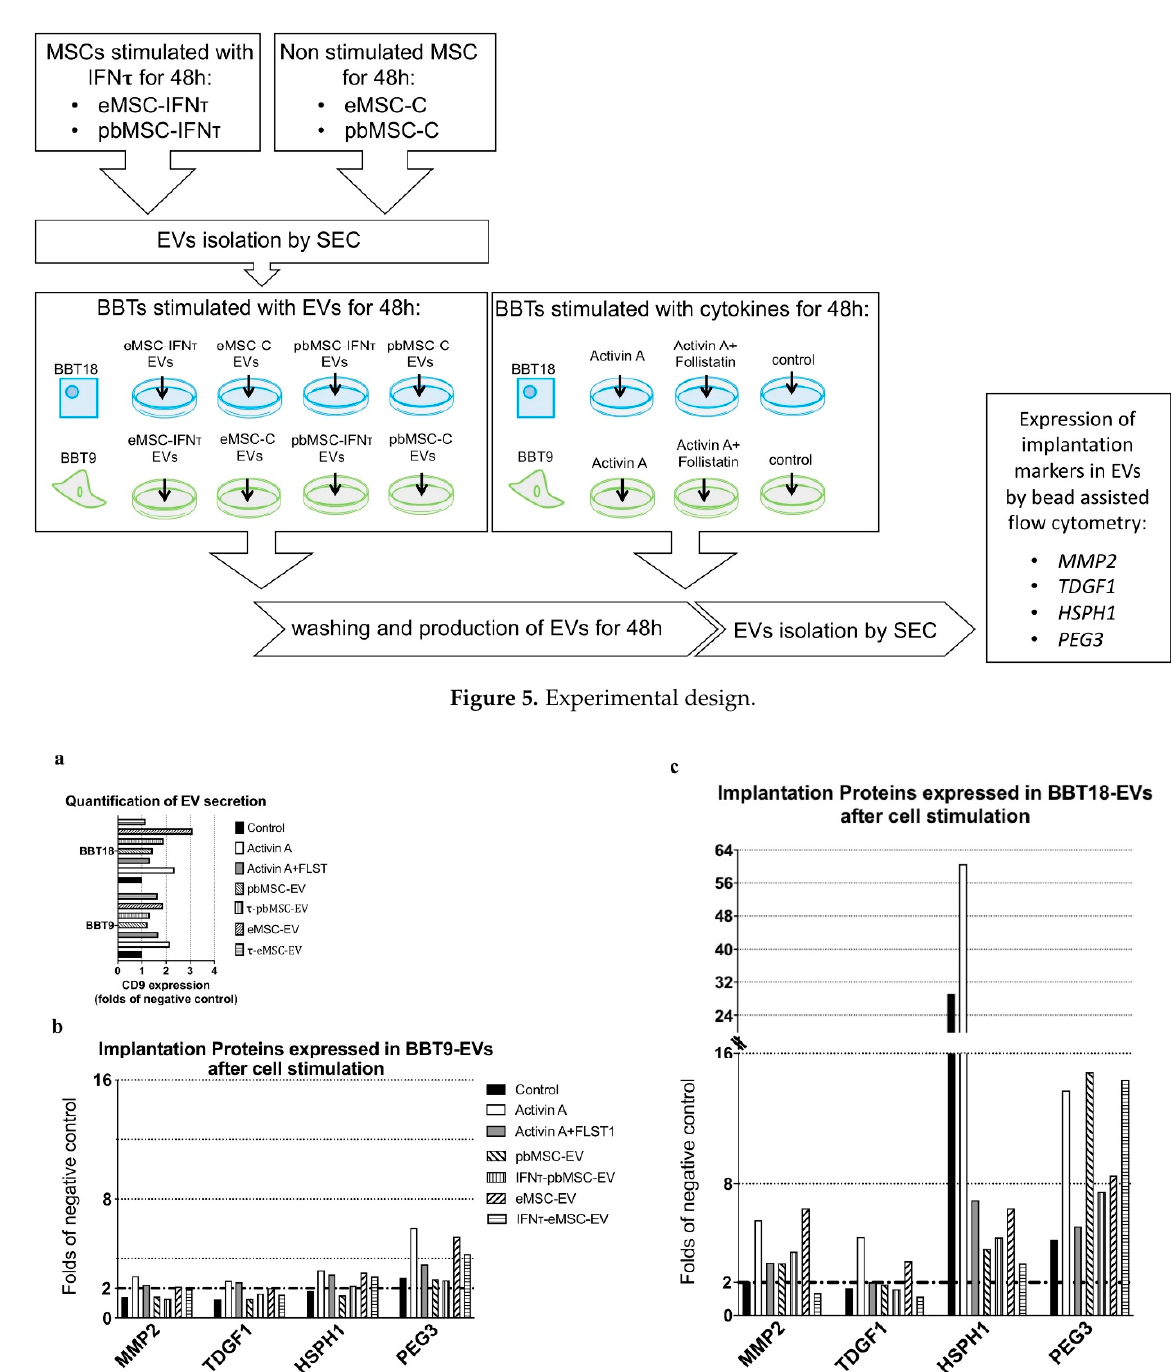
Figure 6. BBT secret implantation proteins on EVs, and their secretion pattern, which is altered after the uptake of MSC-EVs or the presence of uterine cytokines. SEC-elution profile of EVs from BBT-9 and BBT-18 for the different experimental conditions (Control, Activin A, Activin A+FLST, pbMSC-EVs, τ -pbMSC-EVs, eMSC-EVs, and τ -eMSC-EVs) were analyzed by Dot Blot using an anti-CD9 specific antibody. The positive EV fractions of each experimental condition were quantified by ImageJ software analysis of the dot blot results ( a ). Bead-assisted flow cytometry analysis of selected implantation proteins expressed in BBT-9- ( b ) and BBT-18-EVs ( c ) after cell stimulation.